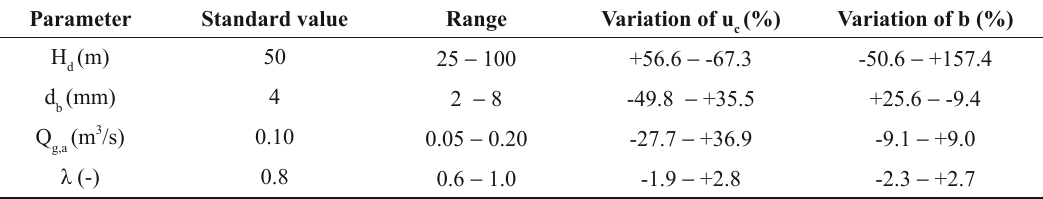
Sensitivity analysis of the present model: oxygenation mode.